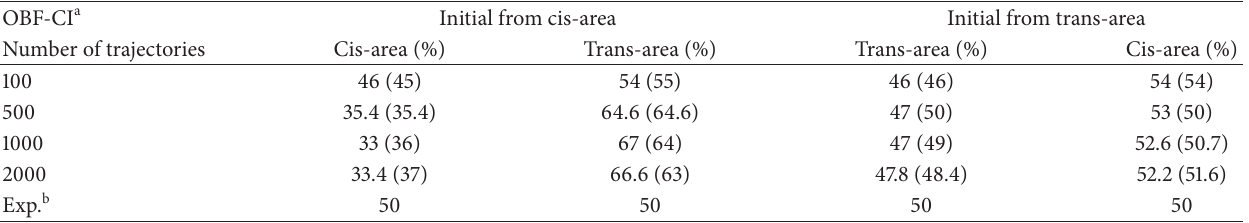
Table 2: Branching ratios (numbers in parentheses are calculated from Landau-Zener formula) for cis-to-trans and trans-to-cis isomerizations at one-bond flip conical intersection